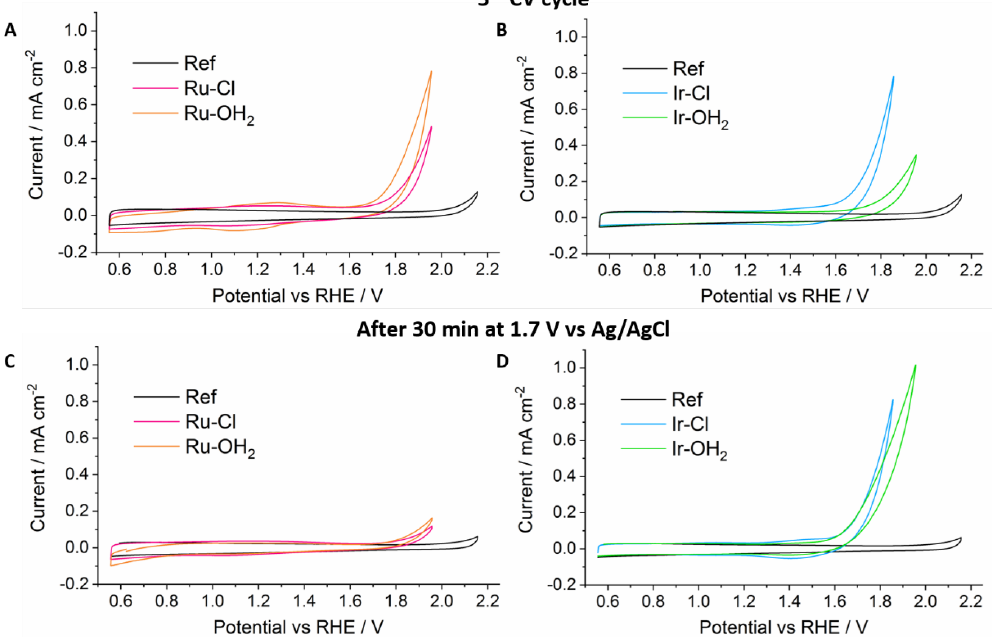
Figure 3. Top: Cyclic voltammetry (CV) scans of Ru–Cl (pink), Ru–OH 2 (orange) ( A ), Ir–Cl (blue) and Ir–OH 2 (green) ( B ) before chronoamperometry at 1.95 V vs. RHE. Bottom: CV scans of Ru–Cl (pink), Ru–OH 2 (orange) ( C ), Ir–Cl (blue) and Ir–OH 2 (green) ( D ) after chronoamperometry. CVs were recorded at 50 mV/s in 0.1 M H 2 SO 4 with a Pt counter electrode. Ref is meso-ITO with 30 cycles ALD-TiO 2 .